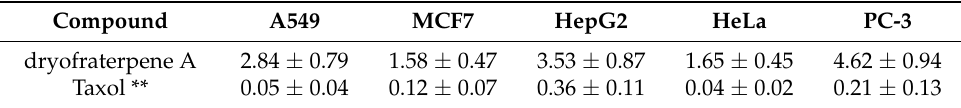
Table 2. In vitro cytotoxicity of dryofraterpene A against five cancer cell lines